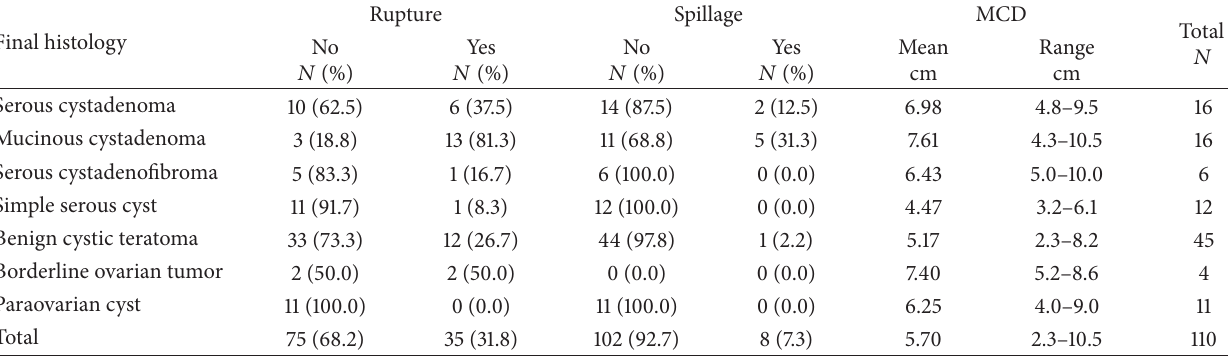
Table 1: Distribution of our cases according to the final histological